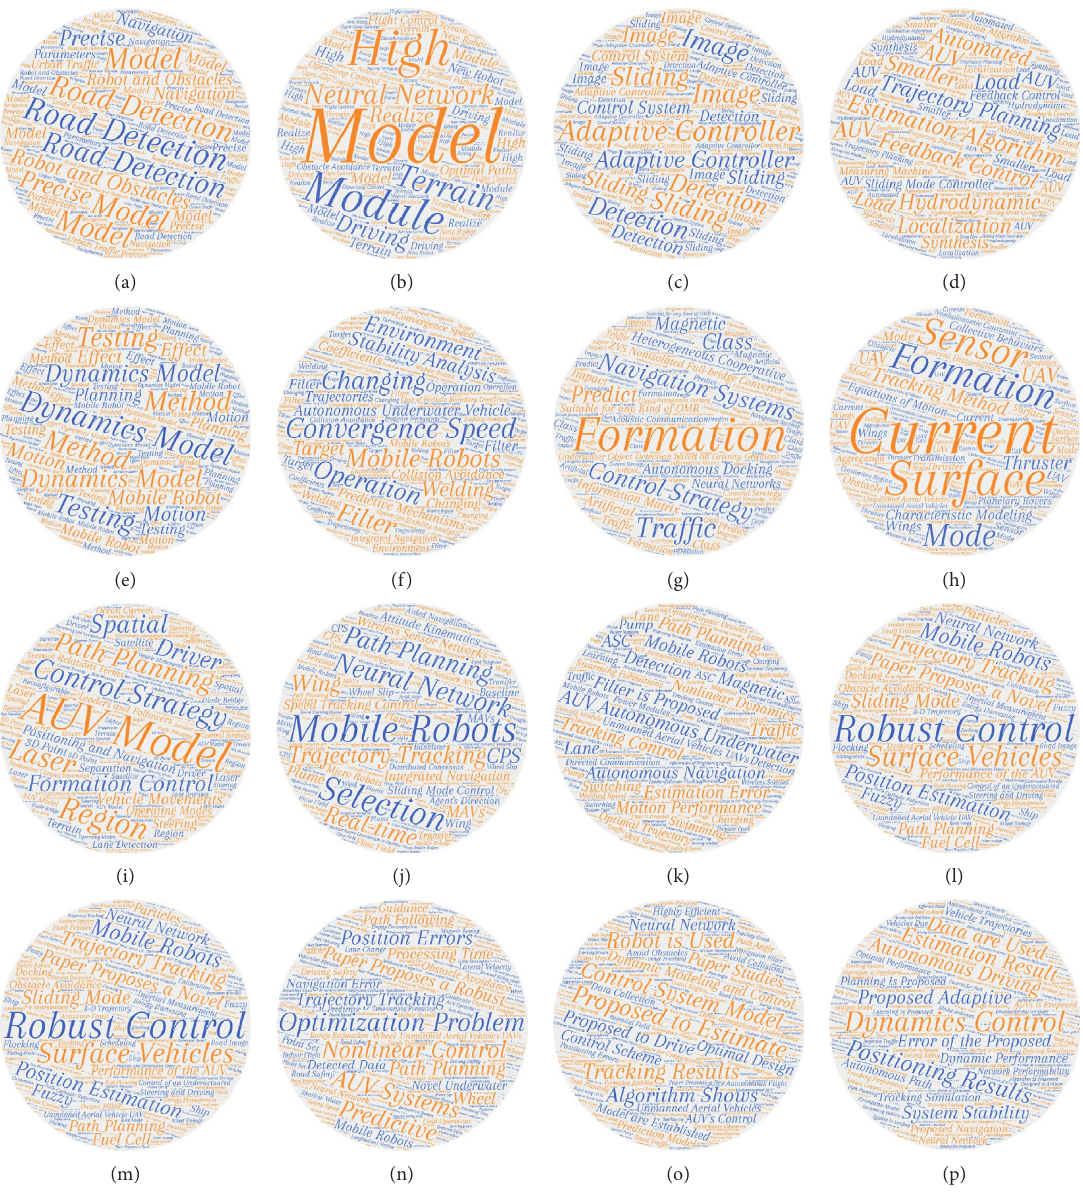
Figure 5: Clustering results of papers: (a) 2004; (b) 2005; (c) 2006; (d) 2007; (e) 2008; (f) 2009; (g) 2010; (h) 2011; (i) 2012; (j) 2013; (k) 2014; (l) 2015; (m) 2016; (n) 2017; (o) 2018; (p)